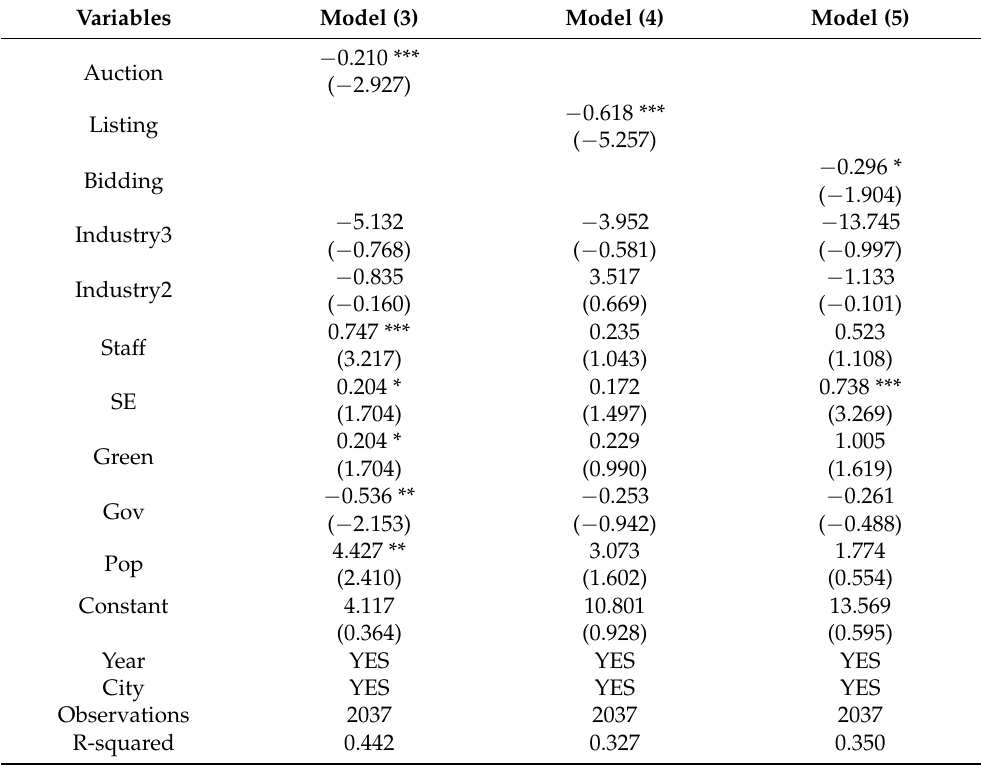
Table 5. Regression results of land transaction modes and urban carbon